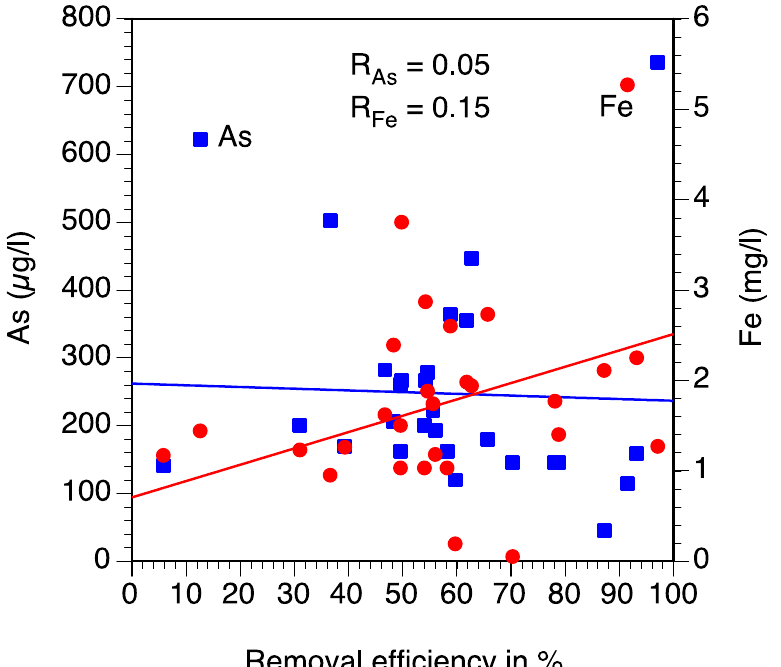
Figure 2. Overall removal efficiency from 2015 in terms of the dependence from Fe and As concentrations in ground water. Correlation coefficients are included.